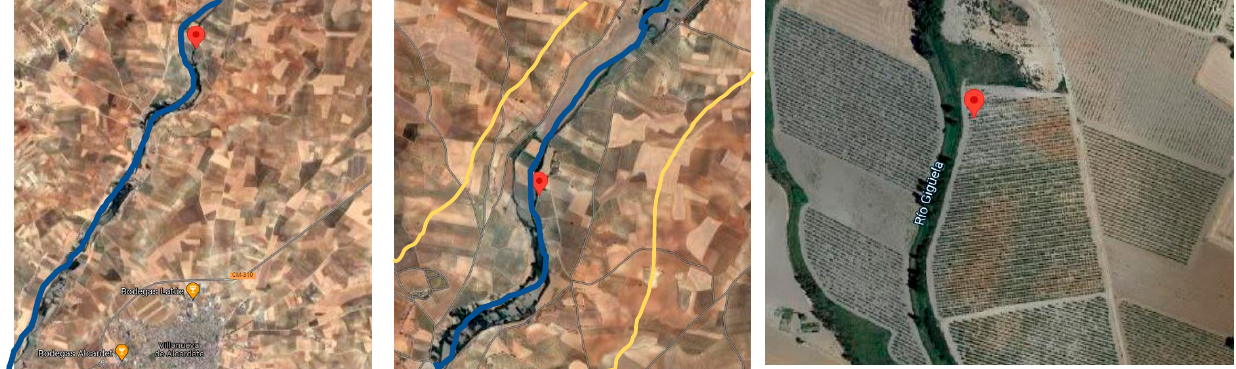
Figure 1. Location of the soil profile, derived from Google Earth. The blue line indicates the Cigüela river and the yellow line shows the area, with the presence of redox conditions. Soil profile situated at .